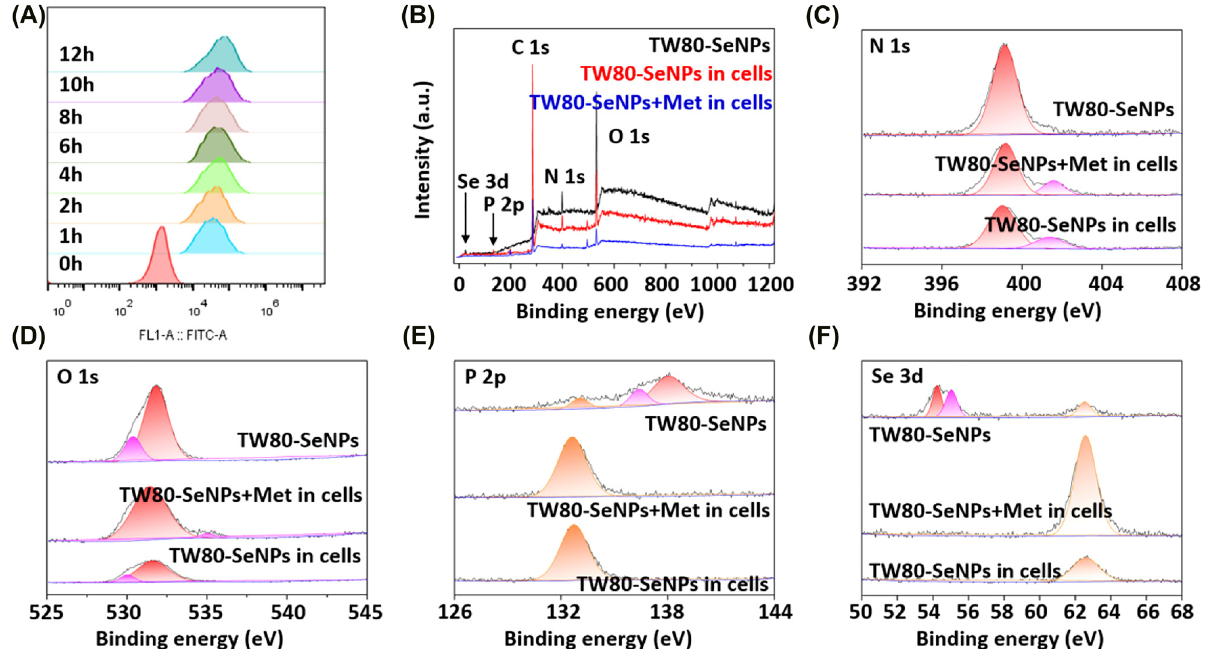
Figure 5: TW80-SeNPs absorption and transformation in MG63 cells. (A) Se uptake in MG63 cells. (B) XPS spectra of MG63 cells, (C) N 1s spectra, (D) O 1s spectra, (E) P 2p spectra, and (F) Se 3d spectra of MG63 cells after TW80-SeNPs and TW80-SeNPs + met